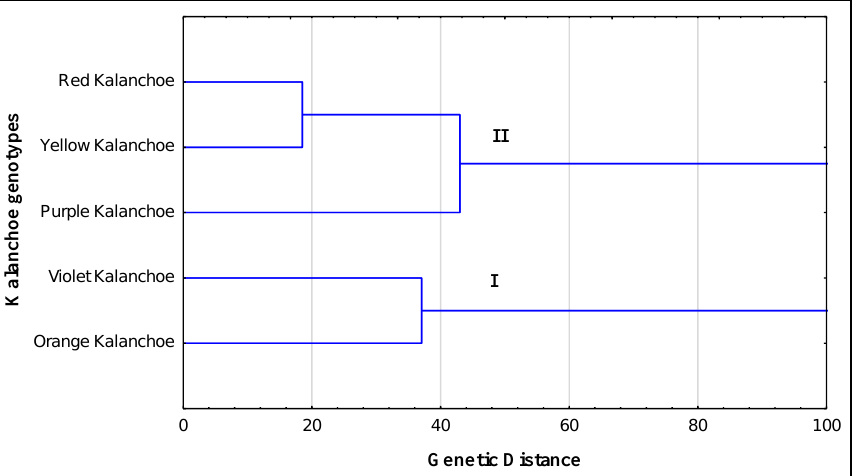
Figure 4. Phylogenetic tree of five kalanchoe genotypes revealed by the weighted pair group method using arithmetic average (WPGMA) method based on morphological features.